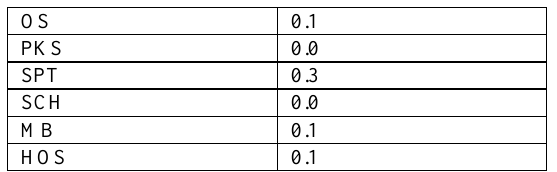
Table 5: Knowledge Based Weighting Table 2.4 Quantification of Heterogeneity in the Land Use Pattern From section 2.3 above, five main land use classes,